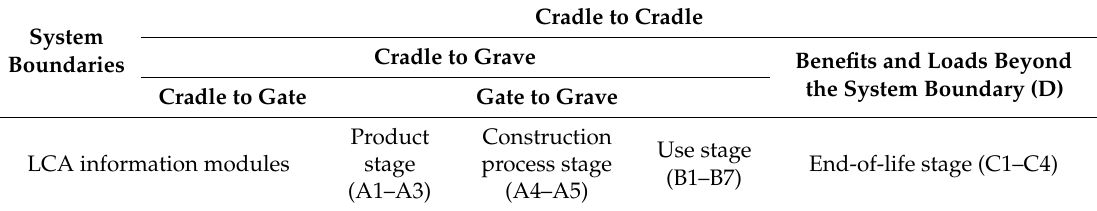
Table 2. Life cycle stages of building materials classification based on European standards, including the corresponding system boundaries [11].